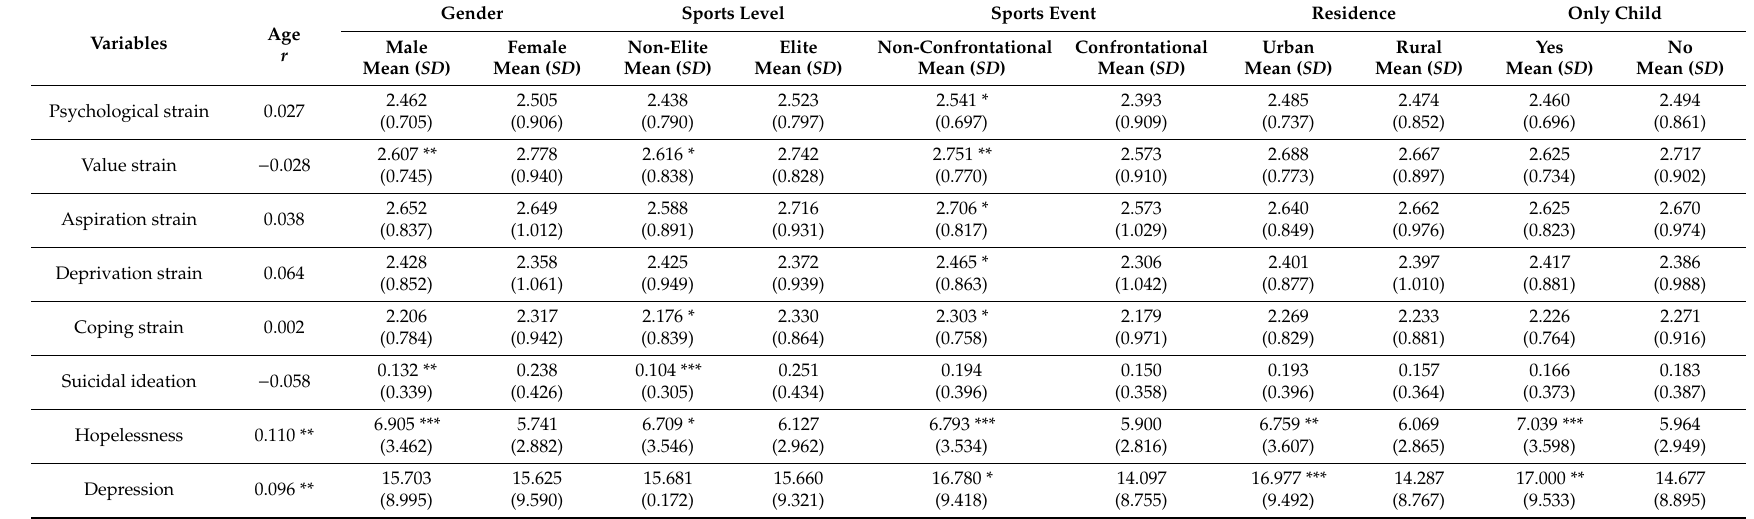
Table 2. The associations of demographic variables with psychological strain, suicidal ideation, hopelessness, and